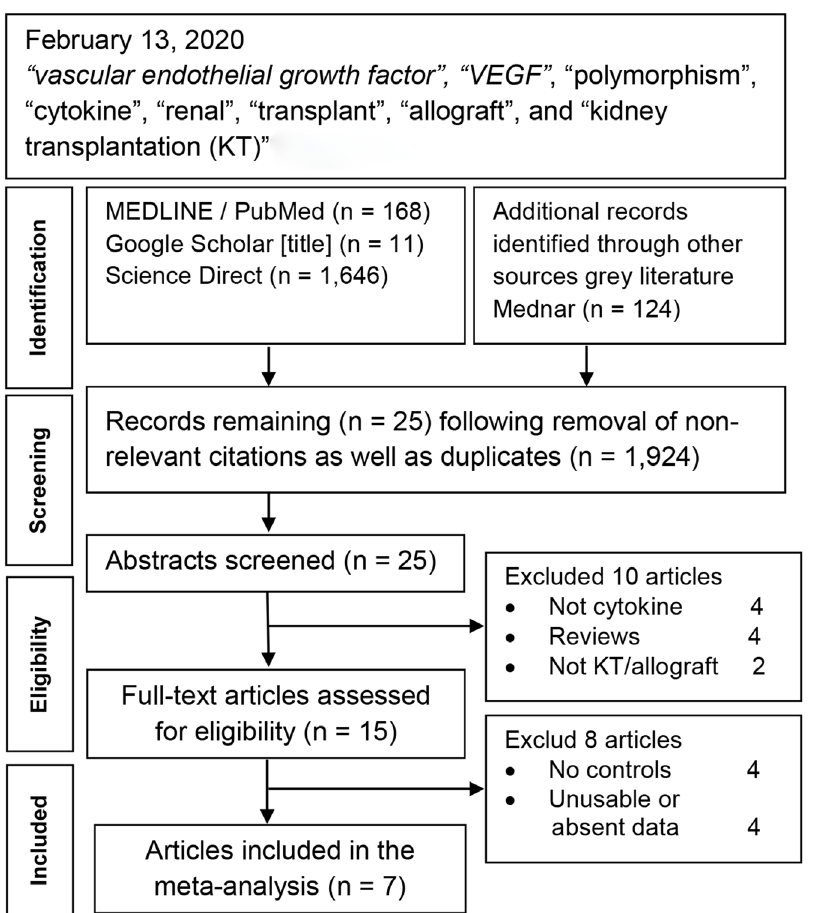
Figure 1. Summary flowchart of literature